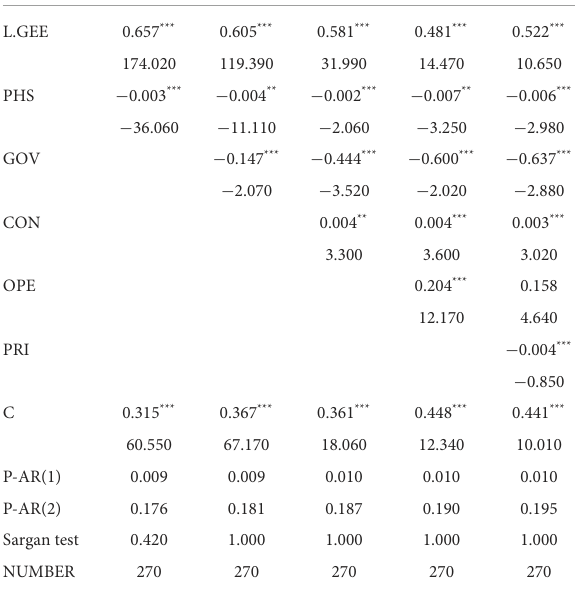
TABLE 11 Endogeneity